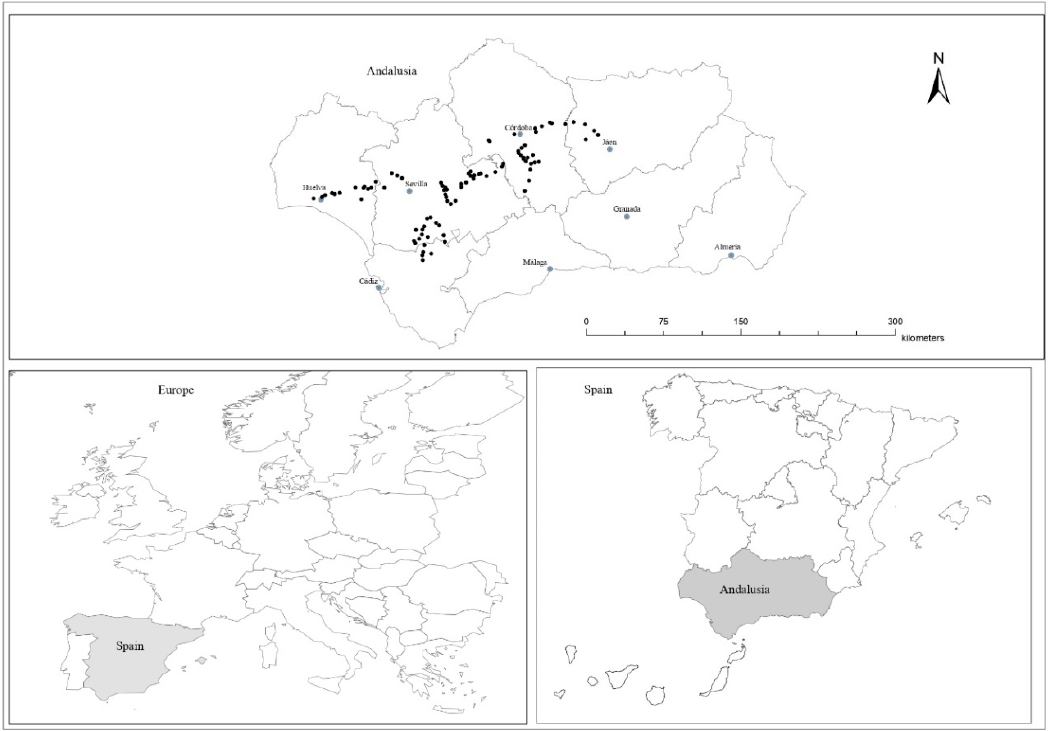
Figure 3. Map showing the location of the 94 sampled margins.